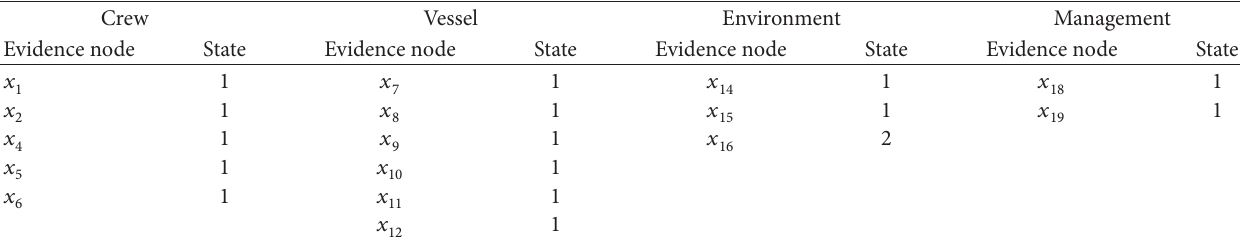
Table 8: Node states of the testing ship at the Qiongzhou Strait.